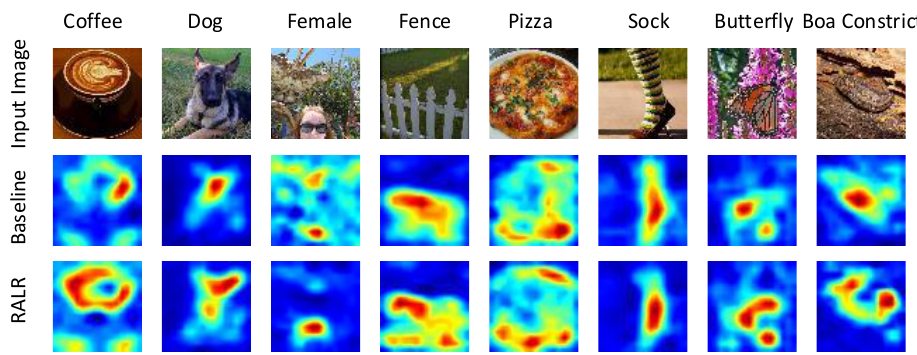
Figure 3. The first line shows the part of the original images of the Tiny-ImageNet test dataset. The second line shows the localized class-discriminative regions with ResNet-110 training with the traditional way. The third line shows the localized class-discriminative regions with ResNet-110 training with